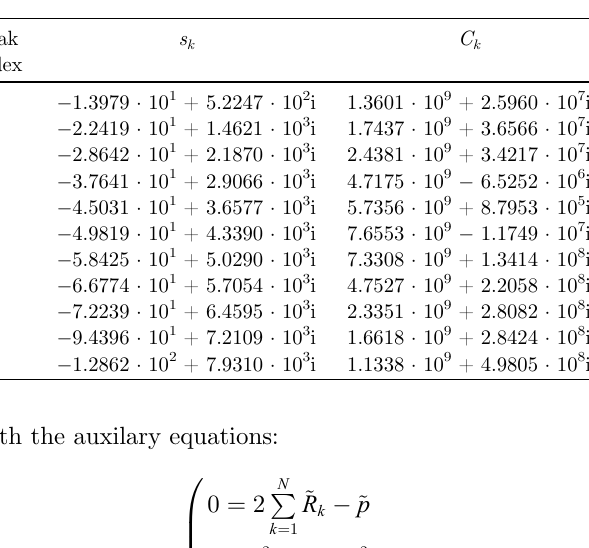
Figure 1. Measured input impedance (dashed black) and reconstructed input impedance from 11 complex modes (red) for a B [ trumpet with open fi ngering. Table 1. Values of poles and residues extracted from the input impedance of a B [ trumpet with open fi ngering using the ESPRIT method.